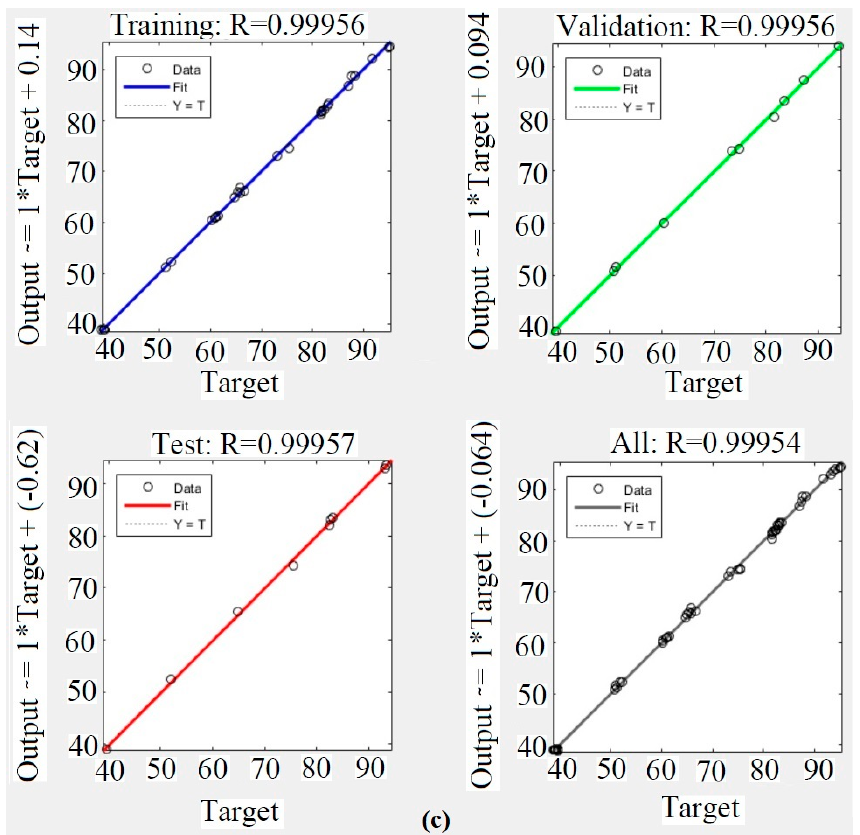
Figure 9. Model prediction versus experimental values for the optimum topology for diclofenac ( a ), ibuprofen ( b ), and naproxen ( c ). Table 3. R 2 and MSE values for the removal of each pollutant in the selection of the best model.